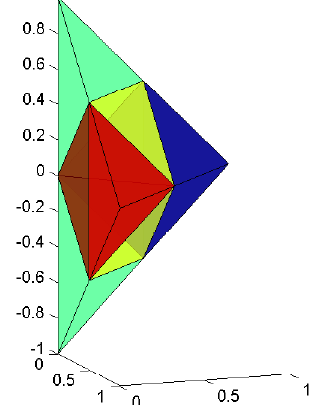
Figure 4. The subdivision of a T cell.